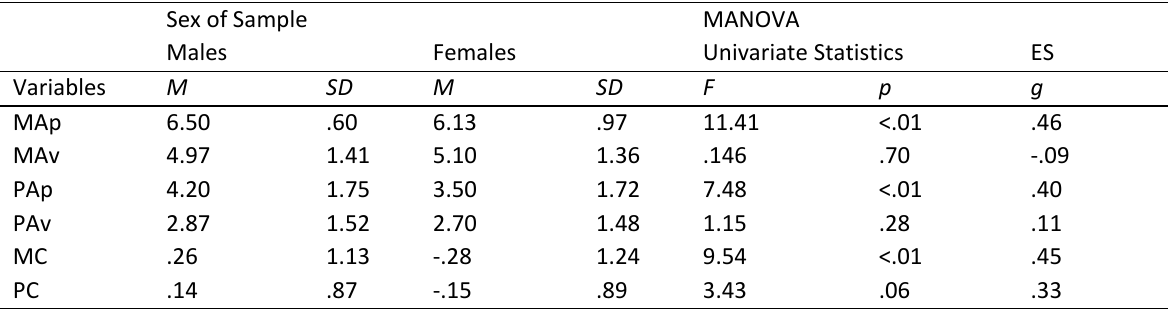
Table 4. Descriptive data, univariate statistics, and effect size values for sex analyses Sex of Sample